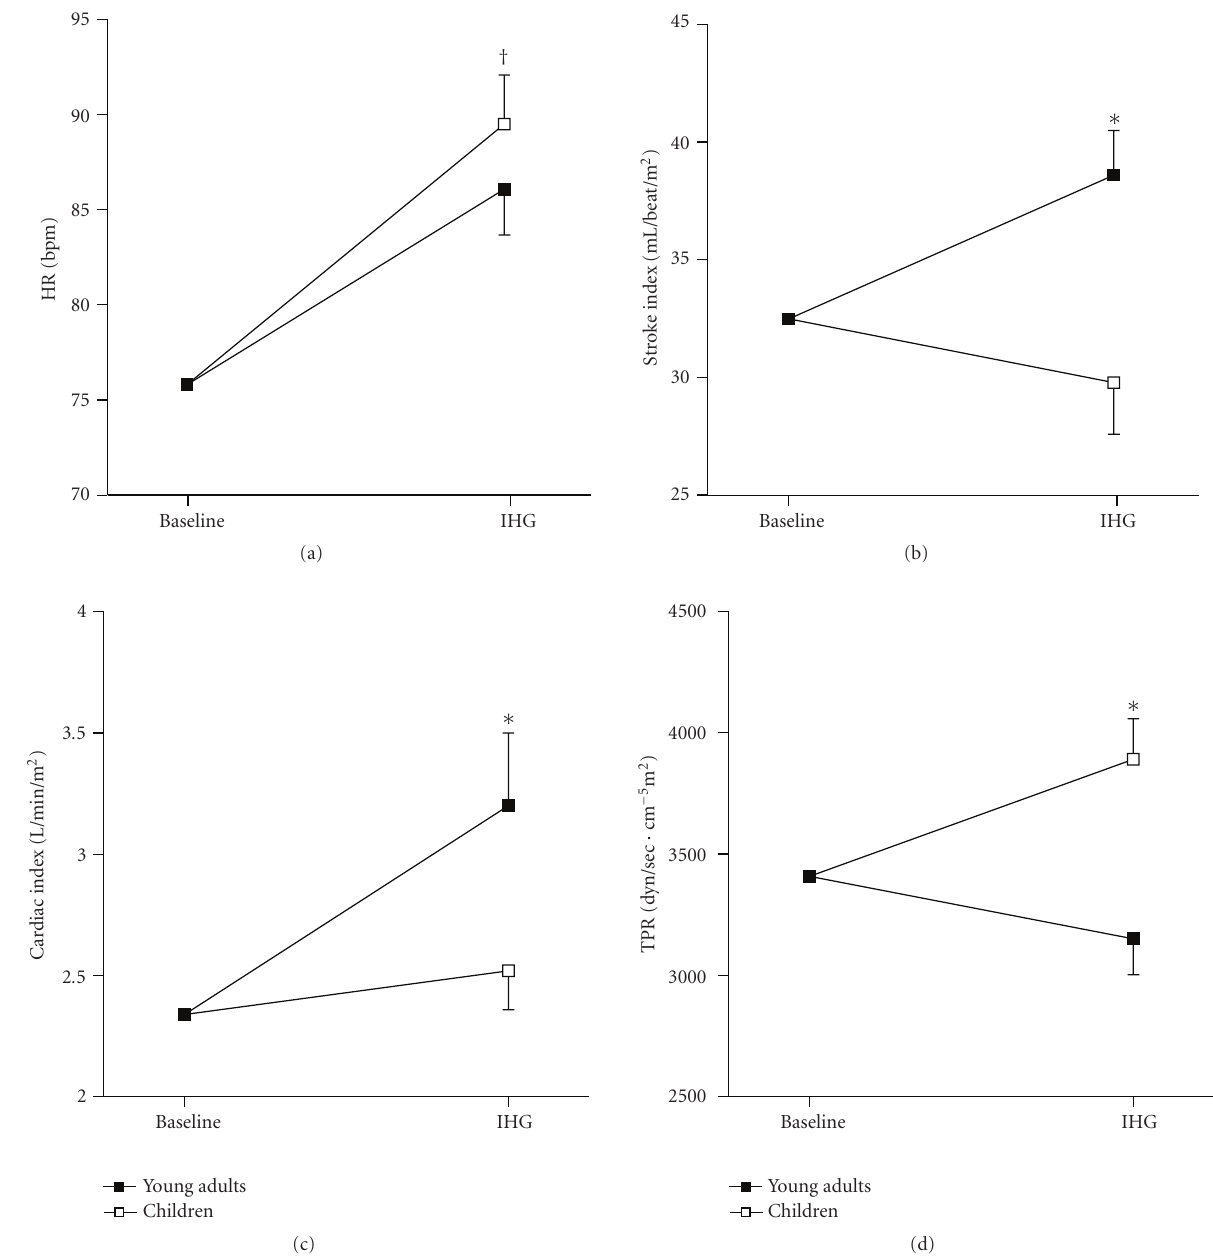
Figure 2: Heart rate (a), stroke index (b), cardiac index (c), and total peripheral resistance (2D) responses to isometric handgrip exercise in children and young adults. HR: heart rate; TPR: total peripheral resistance; IHG: isometric handgrip exercise. The adjusted means (adjusted to the influence of the covariates) are presented as means ± SE. ∗ P < . 05, task by group interaction; † P < . 05, task e ff